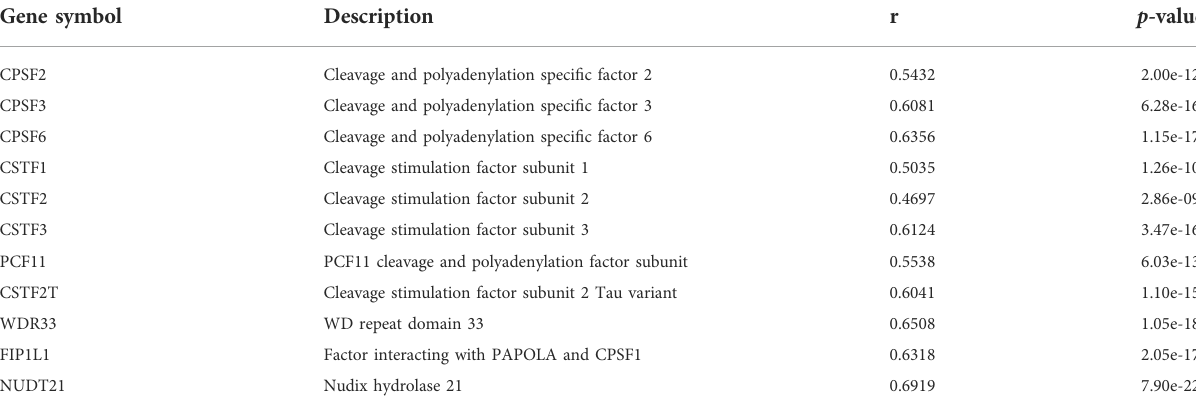
TABLE 2 Gene expression correlation between PCM1 and APA regulatory factors in AML. Gene